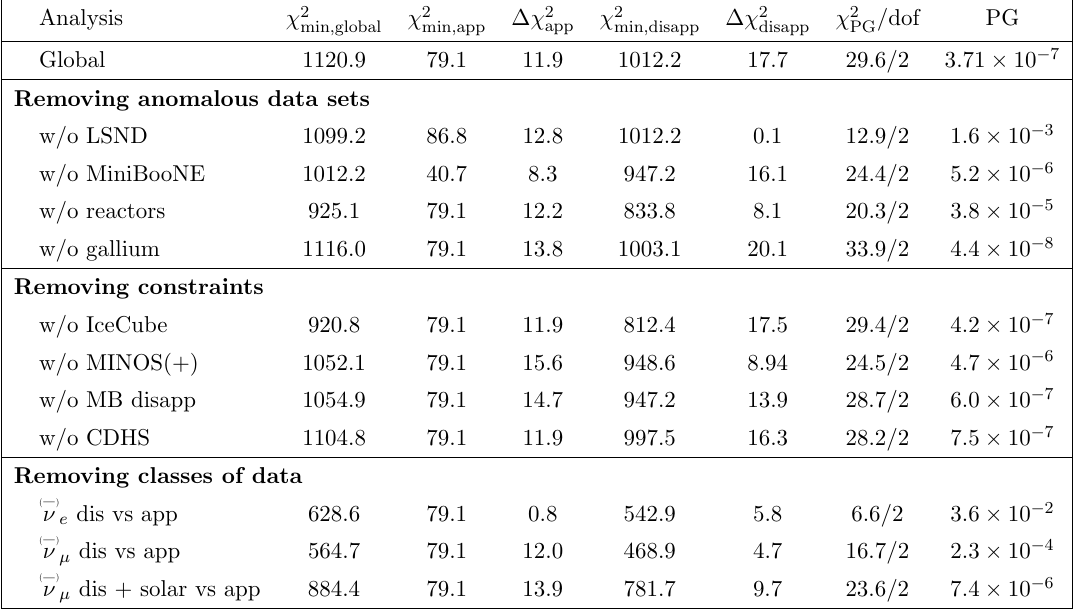
Table 7 . Results of the parameter goodness-of-(cid:12)t (PG) test [92] comparing appearance to dis- appearance data. In this table we use the reactor (cid:13)ux-free analysis and LSND DaR+DiF data; therefore we do not quote dof for the (cid:31) 2 values. The (cid:12)rst row corresponds to the global (cid:12)t,